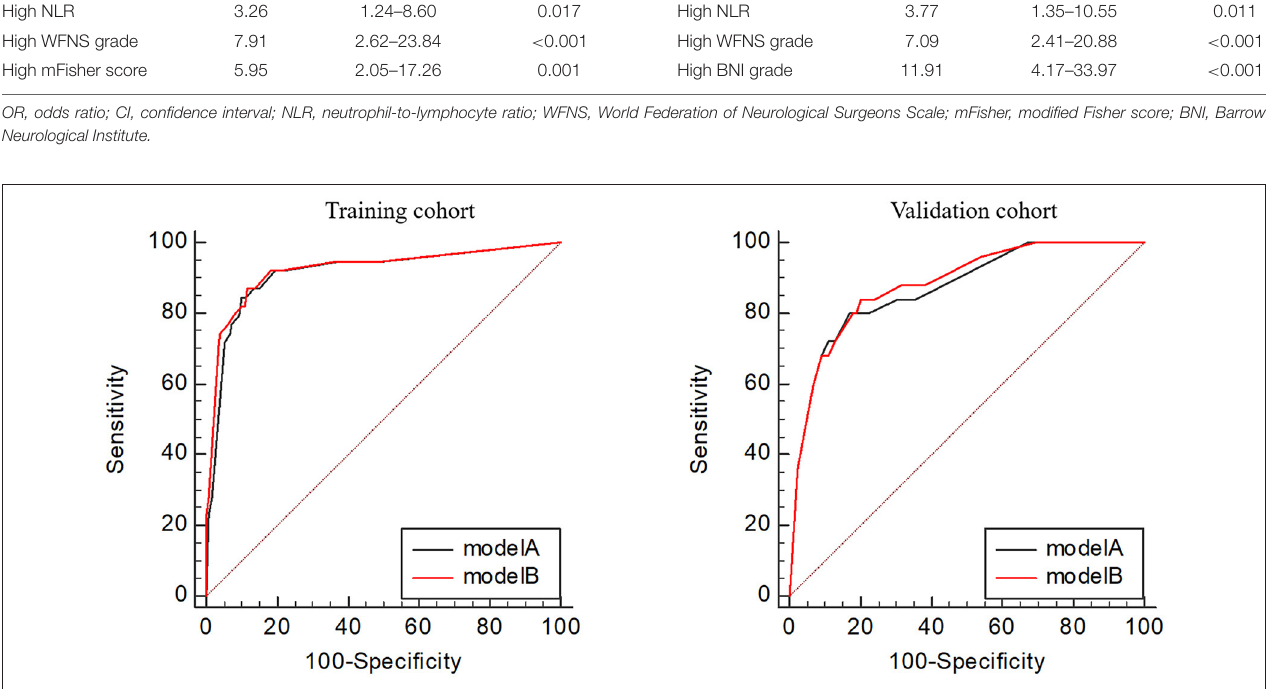
FIGURE 2 | Receiver operating characteristic curves of the two models in the training and validation cohorts.